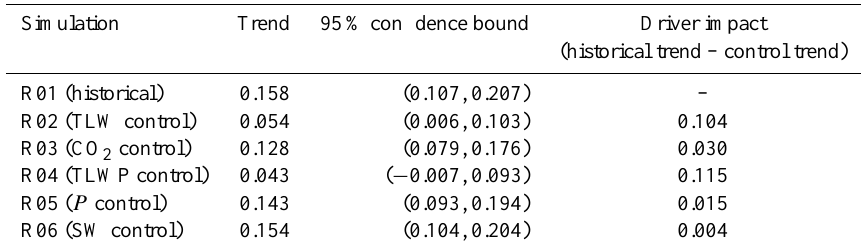
Table 4. Trends in CH 4 emissions from historical and control simulations from 1960 to 2006. All values are in units of TgCH 4 yr − 1